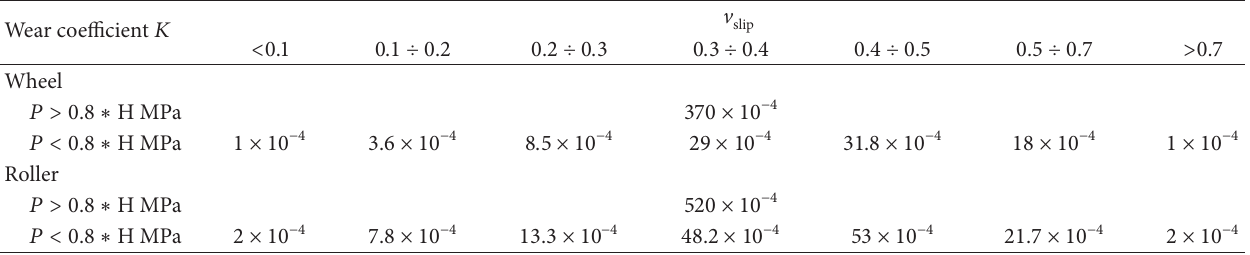
Table 3: Values of the wear coefficient used in this work: the coefficient 𝐾 is expressed in m/km rolled. Wear coefficient 𝐾